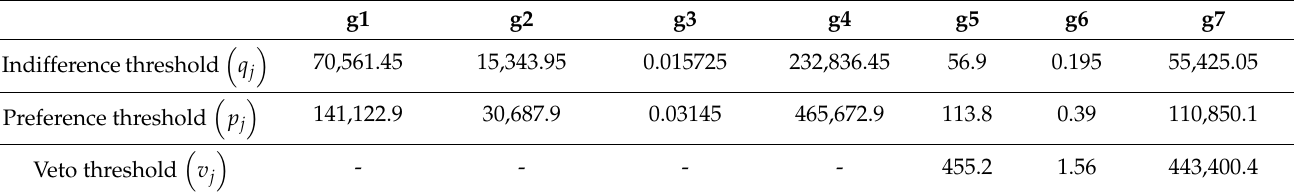
Table 20. Values of thresholds and vetoes on environmental criteria. g1